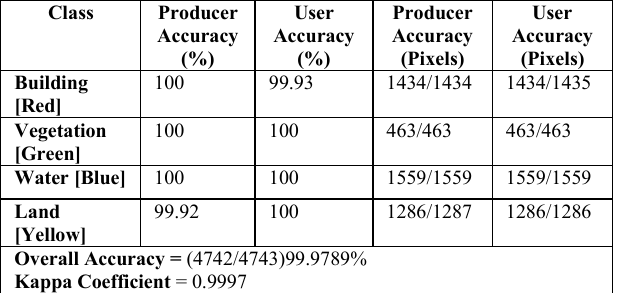
Table 3. Accuracy Indices Evaluated